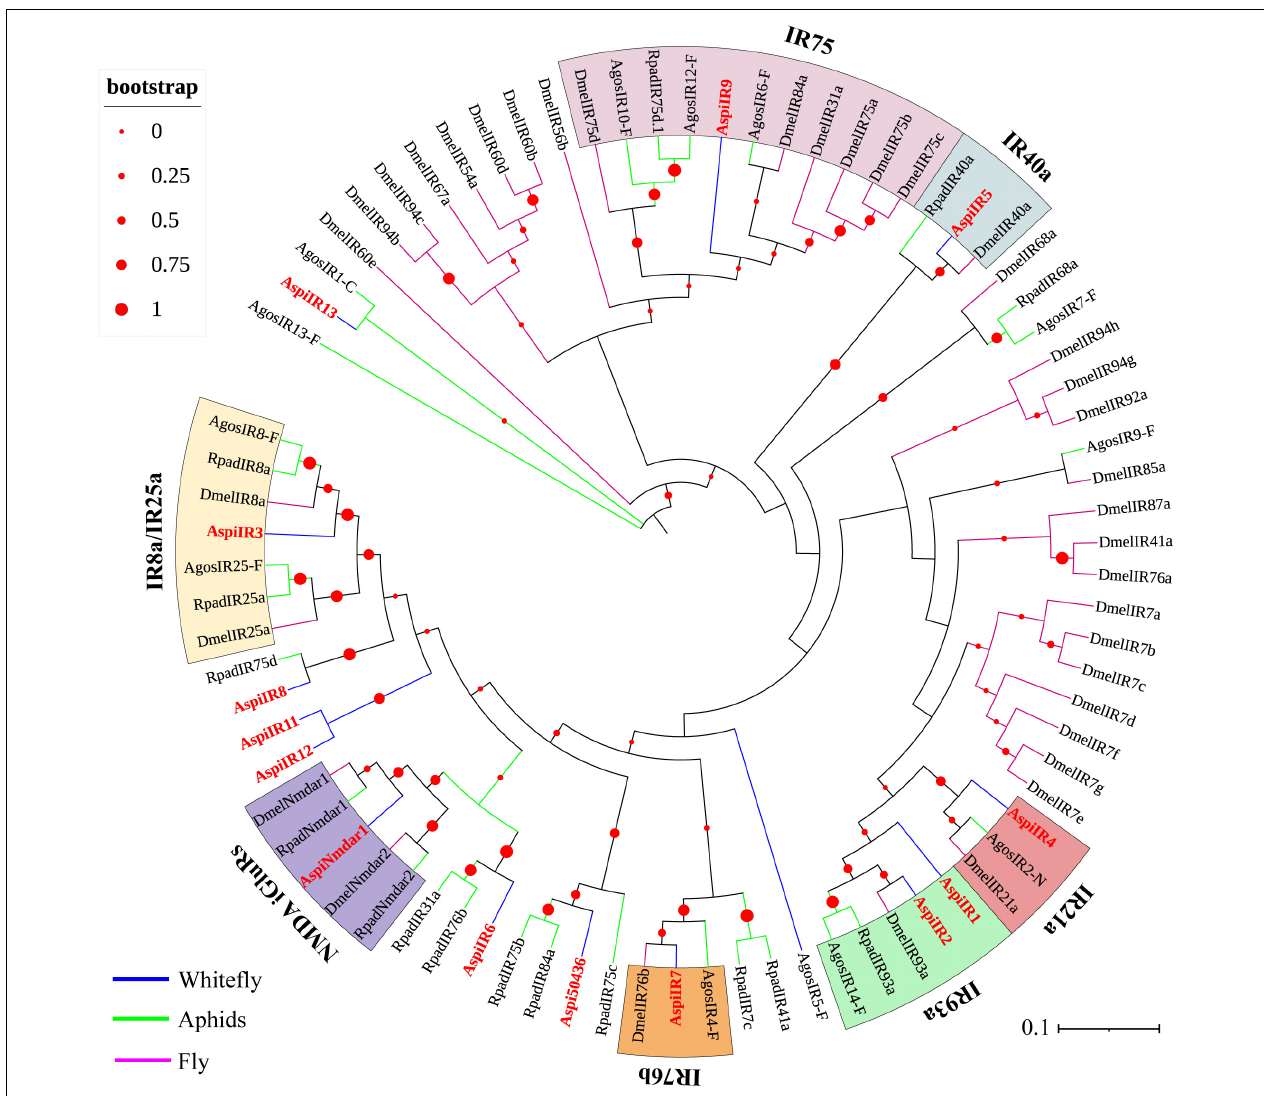
FIGURE 7 | Phylogenetic analysis of putative ionotropic receptors (IRs) of A. spiniferus . The phylogenetic tree was built using IR sequences from whitefly specie (Aspi, A. spiniferus ), aphid species (Apis, A. pisum ; Rpad, R. padi ; Agos, A. gossypii ) and fly ( Drosophila melanogaster